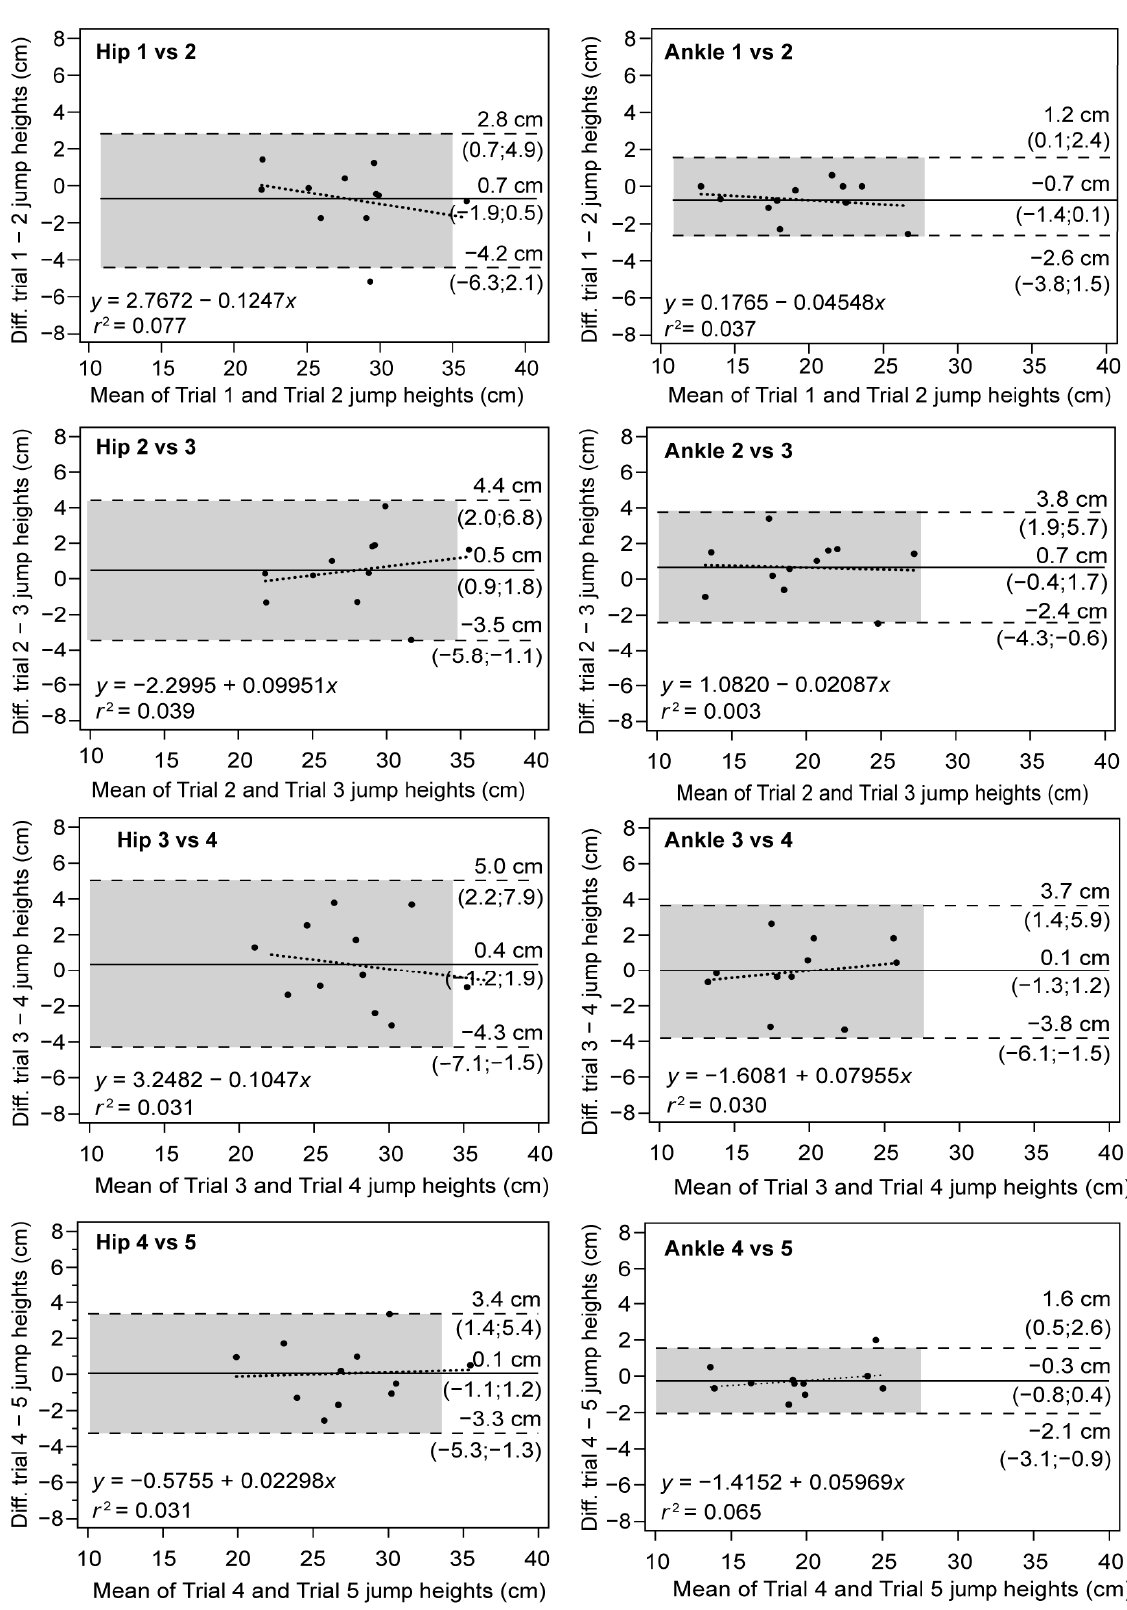
Figure 2. Bland–Altman plots for differences between jumps with the Vmaxpro placed on the hip ( left ) and ankle ( right ). Solid lines: mean differences (systematic error); dashed lines: upper and lower LoA (random error); dotted lines: regression line of the differences between devices.